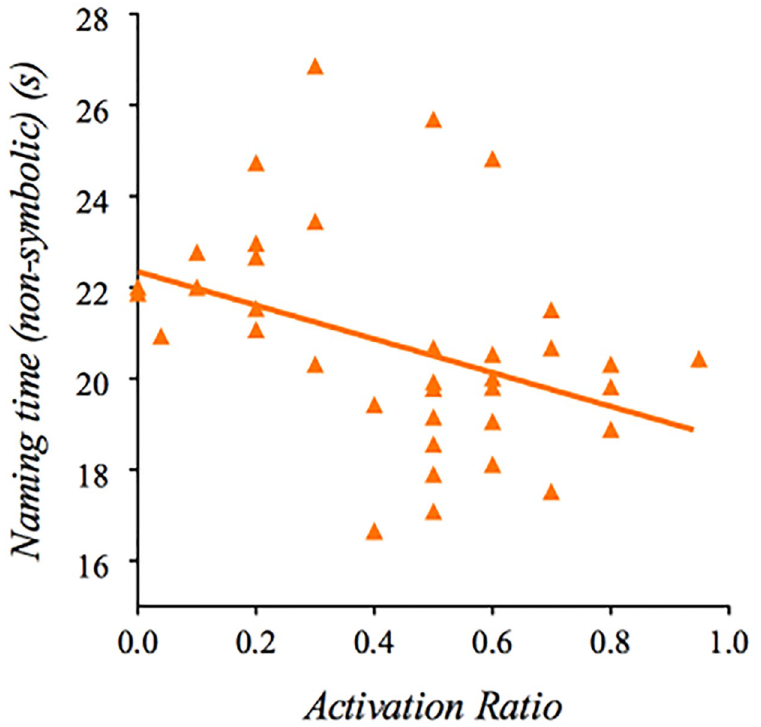
Fig 3. Relationship between RAN performance with molecular-genetic variation. Longer RAN naming time significantly correlated with lower activation ratios in the PM group ( ß = -3.70, p < .05).